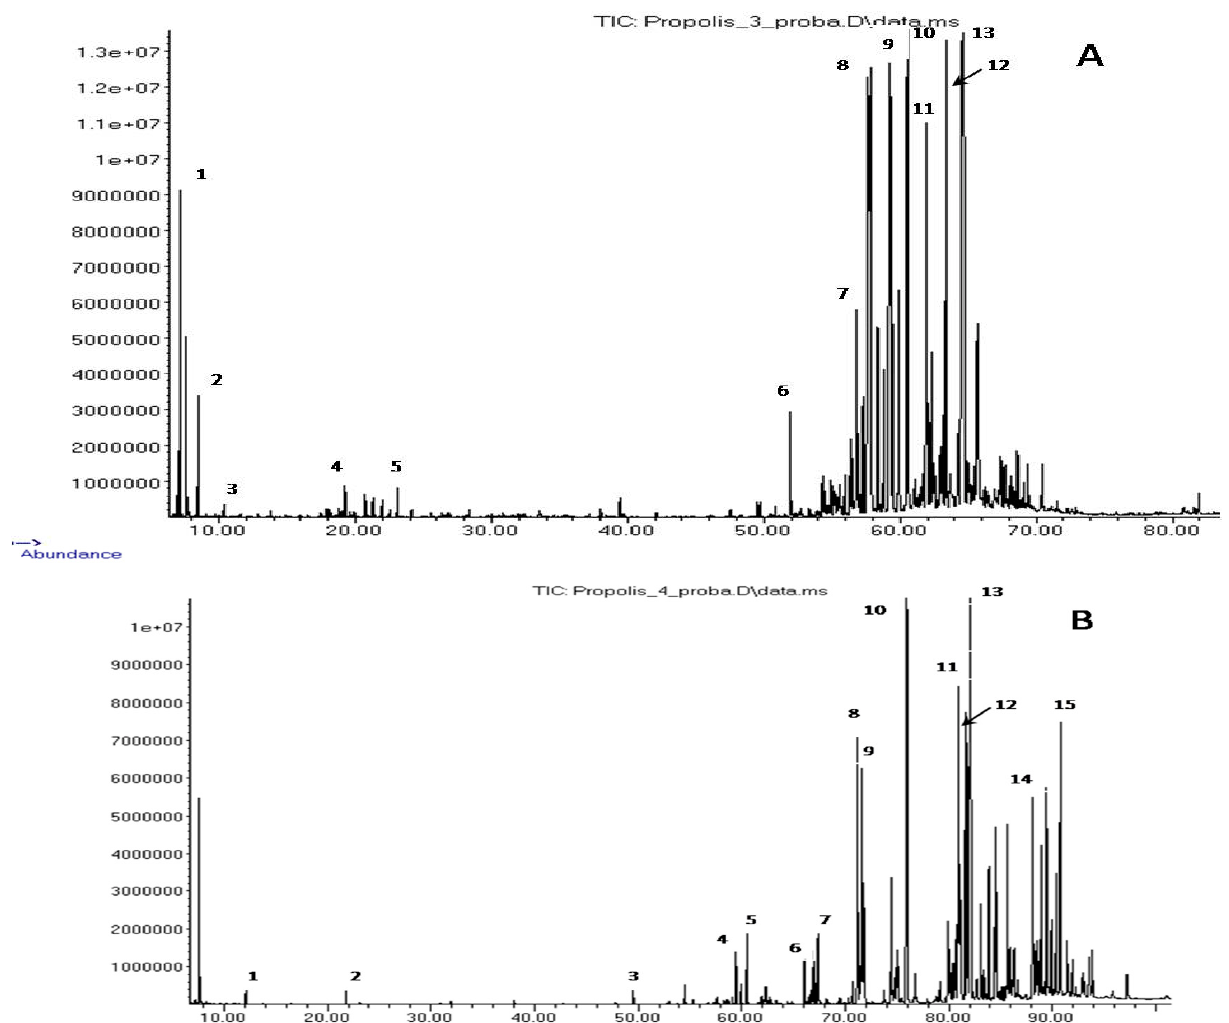
Figure 2. Chromatogram of the extractive components of propolis M. quadrifasciata ( A ) and T.